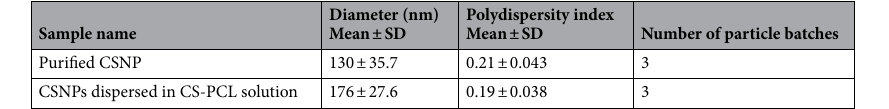
Table 1. CSNPs size properties evaluated by DLS.